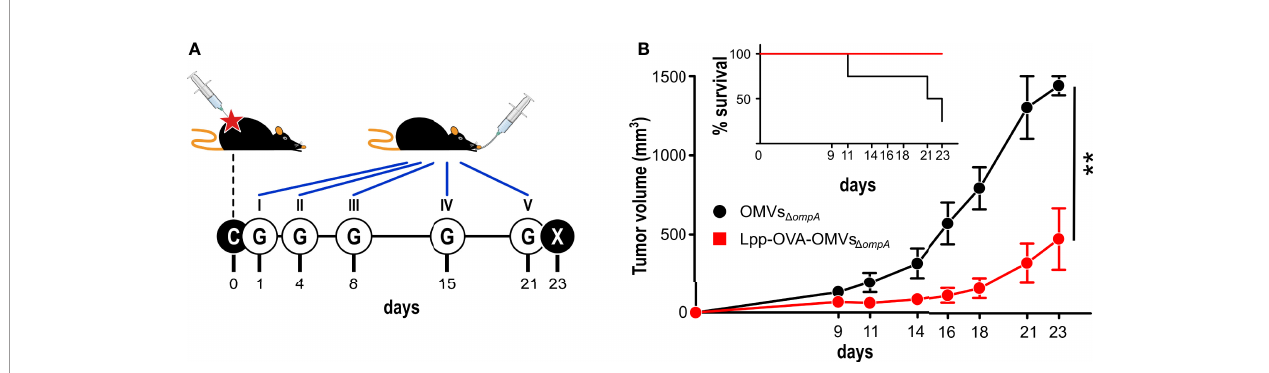
FIGURE 6 | Therapeutic effect of Lpp-OVA-OMVs D ompA . (A) Schematic representation of the therapeutic experimental protocol . C57BL/6 mice (5 animals/group) were challenged with OVA-B16F10 tumor cells and subsequently treated with fi ve oral administrations (G) of either OMVs D ompA or Lpp-OVA-OMVs D ompA (10 m g/ dose) over a period of 23 days. (B) Analysis of tumor growth inhibition . Tumor volumes were measured at three day intervals and the average of tumor volumes from each group is plotted over time. The graph in the inlet shows the survival curve of each group (according to the authorized protocol, animals were sacri fi ced when tumors reached a volume of 1.500 mm 3 ). ( Panel B) report data from one experiment (4 and 5 mice in control and vaccinated group, respectively). Statistical analysis was performed using Student ’ s t-test (two-tailed). **P ≤